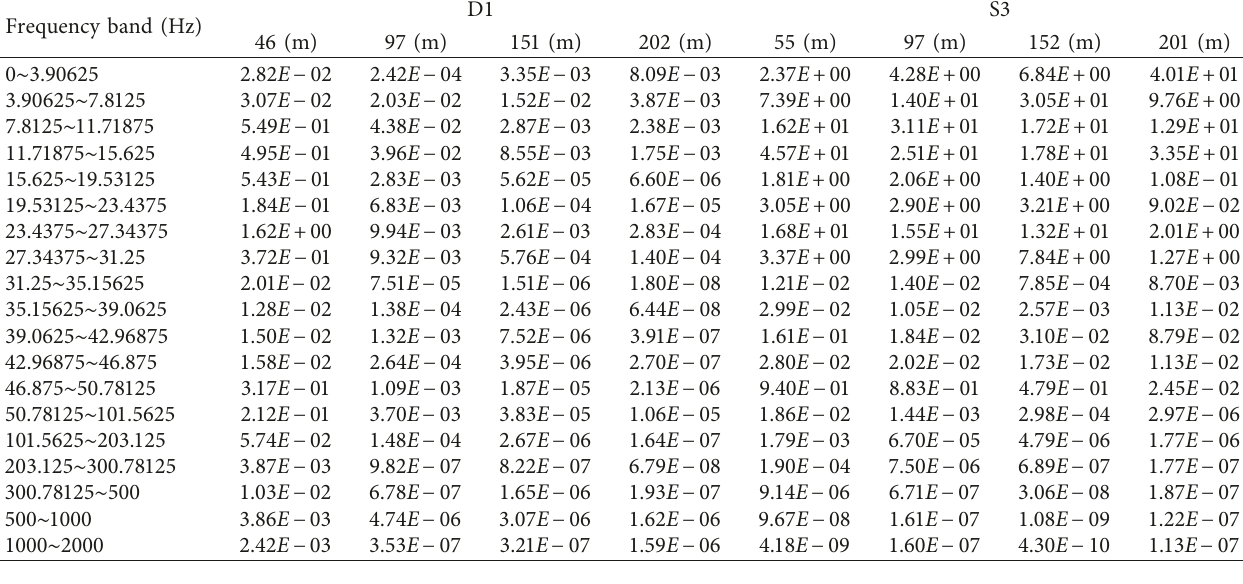
Table 5: The wavelet packet frequency band energy distribution for blasting vibration signals.